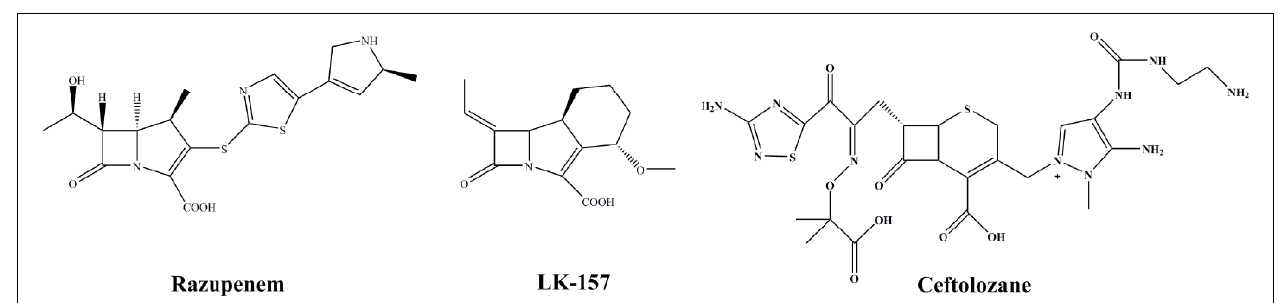
FIGURE 5 | Chemical structures of novel β -lactams with β -lactamase inhibitor activity.